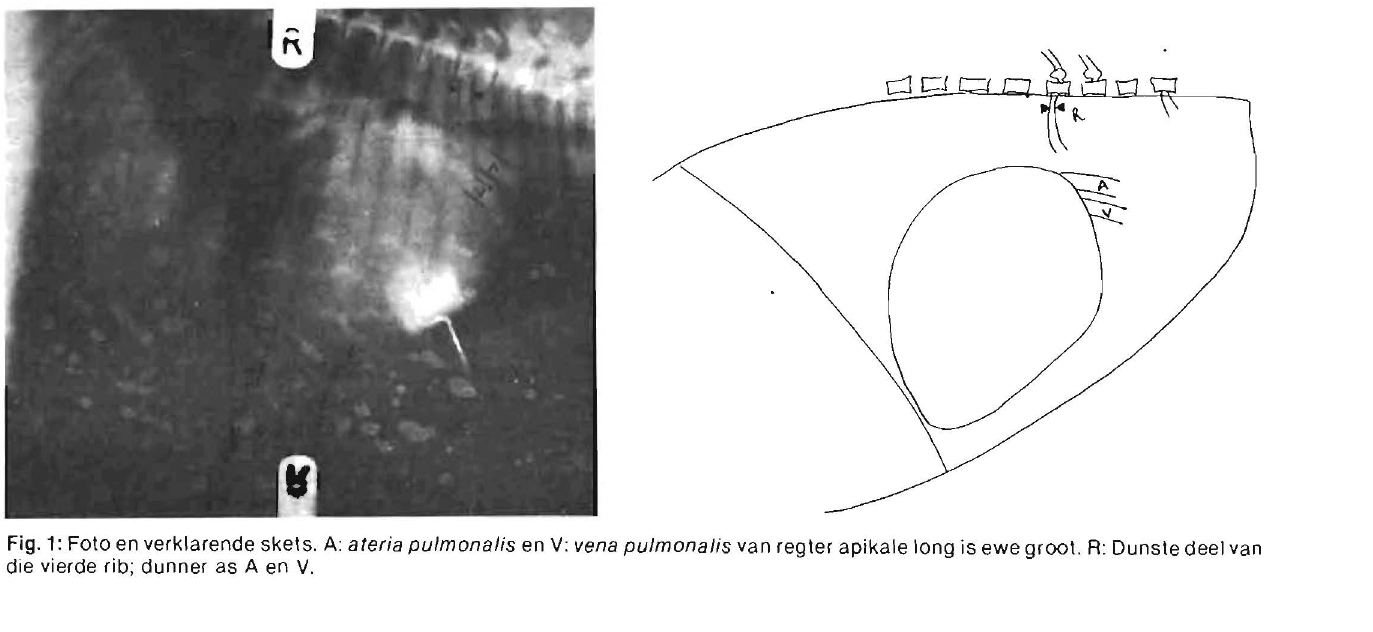
Fig. 1: Folo en verklarende skels. A: ateria pulmonalis en V: vena pulmonalis van regler apikale long is ewe groot. R: Dunsle deel van die vierde rib; dunner as A en V.